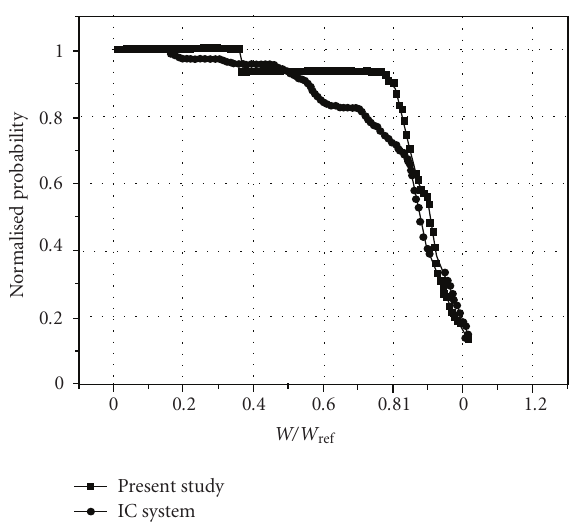
Figure 25: Comparison between thermal hydraulic reliability for two di ff erent systems: IC-SBWR (two-phase NC system) and TTL